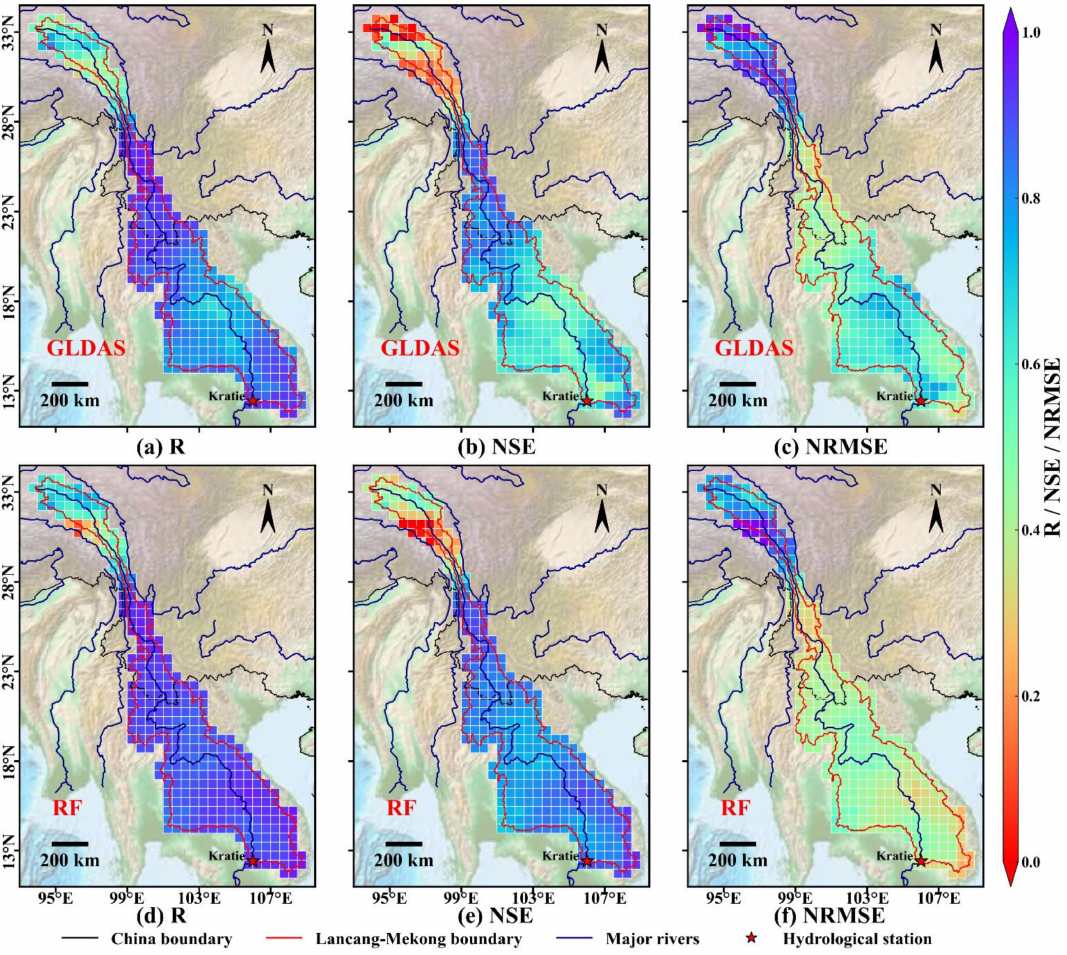
Figure 5. Spatial distribution of the R, NSE, and NRMSE values calculated from the GRACE TWSA and simulated TWSA (GLDAS and RF-built TWSA) for 2003–2014. ( a – c ) represent the analysis results of the GLDAS model, and ( d – f ) represent the RF